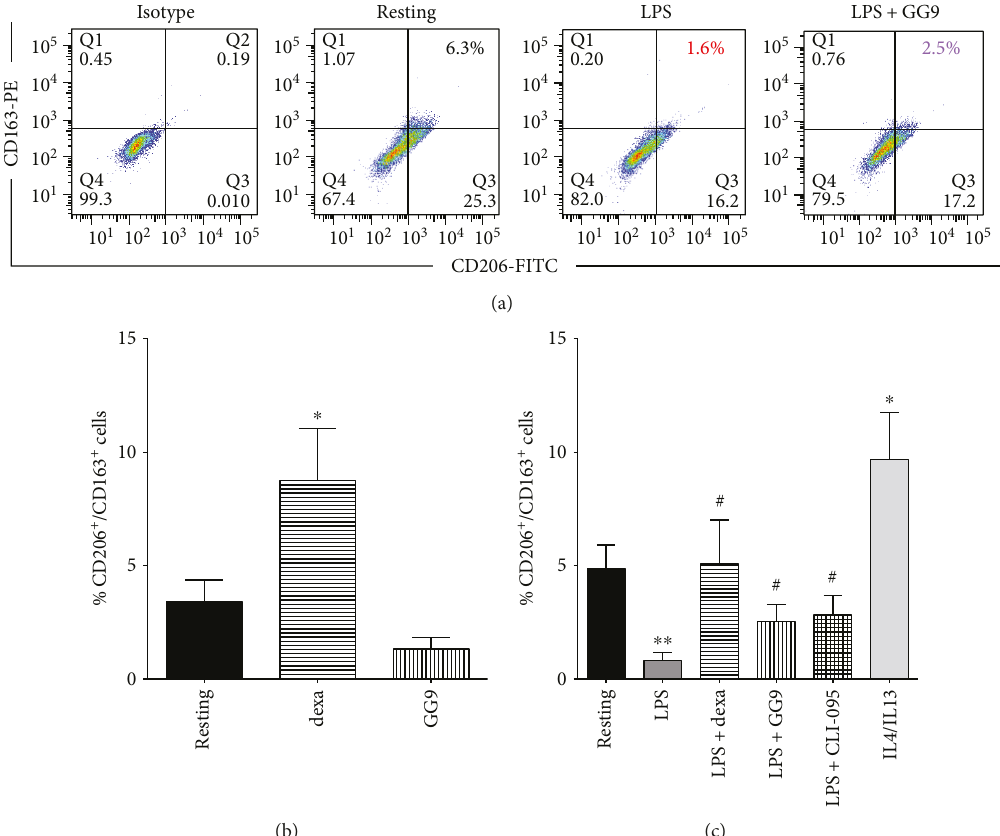
Figure 3: E ff ects of GG9, dexamethasone (dexa), and CLI-095 on the M2 macrophage phenotype as de fi ned by CD206 + /CD163 + cells. Cells were activated and treated as described in the legend to Figure 1. Fluorescence quanti fi cation dot plots (a) are from a representative experiment. (b) Bars represent the mean ( ± SEM) fraction of CD206 + /CD163 + cells after pretreatment with test agents as indicated from 5- 6 independent experiments. (c) Fraction of CD206 + /CD163 + resting macrophages following treatment with test agents for 24h as indicated. ∗ p < 0 05 ; ∗∗ p < 0 005 versus resting; and # p < 0 05 versus